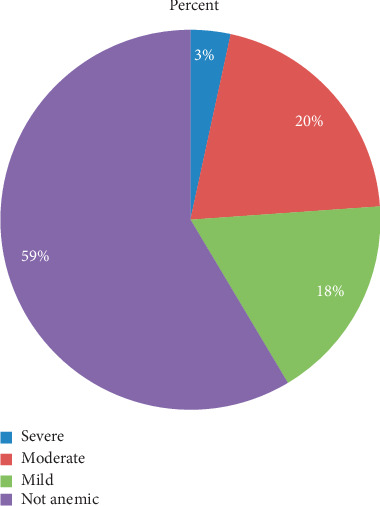
Anemia level among pregnant mothers, EDHS 2016 (n = 3082).